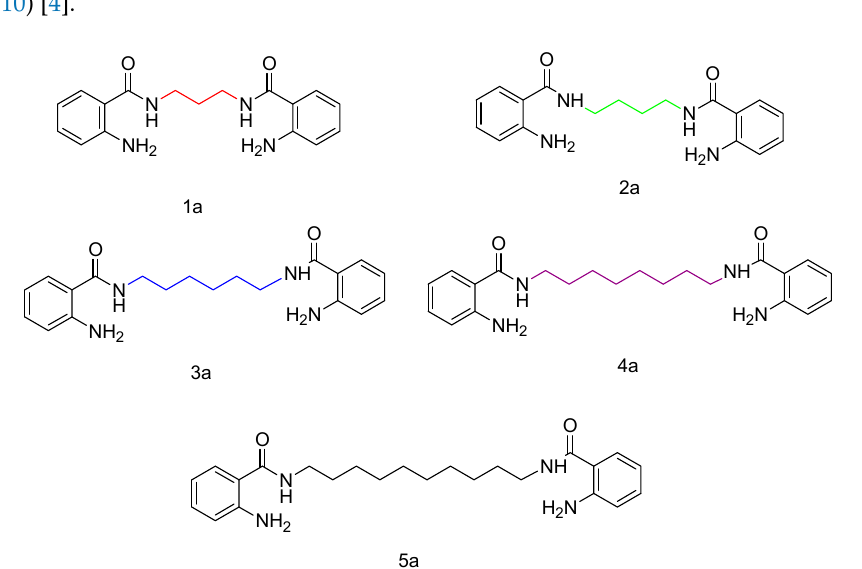
Figure 10. N -alkyl-bis- o -aminobenzamide derivatives 1a –